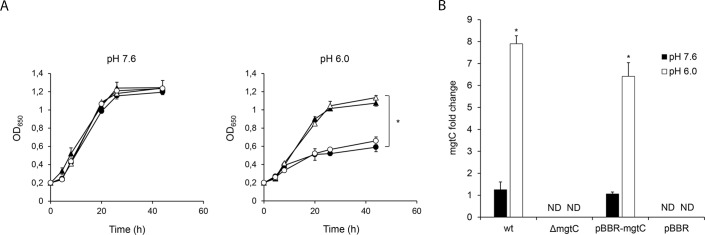
MgtC is required for growth in acid environments.(A) Time course of wild type B. pertussis (wt, filled triangles), B. pertussis mgtC deficient mutant (ΔmgtC, filled circles), B. pertussis mgtC deficient mutant carrying the pBBR1MCS vector (pBBR, open circles), and B. pertussis mgtC deficient mutant carrying a pBBR1MCS derivative that encodes mgtC (pBBR-mgtC, open triangles) growth in SS-MES medium buffered at pH 7.6 or 6.0. The means ± SD of duplicates of one representative experiment out of two performed are given. The maximum OD650 of the wt and pBBR-mgtC strains grown at pH 6.0 were significantly different from the maximum OD650 of the ΔmgtC and pBBR strains. Statistical significance analysis was performed using one-way ANOVA (*P<0.05). (B) The expression level of mgtC of the wt, ΔmgtC, pBBR and pBBR-mgtC strains growing in the SS-MES medium buffered at pH 7.6 or 6.0 was measured by RT-qPCR. The recA gene was used as a housekeeping gene for normalization. The relative expression level of mgtC was calculated by the 2−ΔΔCt method. The means ± SD of duplicates of one representative experiment out of two performed are given. The level of expression of mgtC in wild type B. pertussis growing in SS-MES medium buffered at pH 6.0 was significantly different from the level of expression of mgtC in wild type B. pertussis growing in SS-MES buffered at pH 7.6. Statistical significance analysis was performed using Student's t-test (*P<0.05). The level of expression of mgtC in B. pertussis pBBR-mgtC growing in SS-MES medium buffered at pH 6.0 was significantly different from the level of expression of mgtC in B. pertussis pBBR-mgtC growing in SS-MES buffered at pH 7.6. Statistical significance analysis was performed using Student's t-test (*P<0.05). ND: not detected.